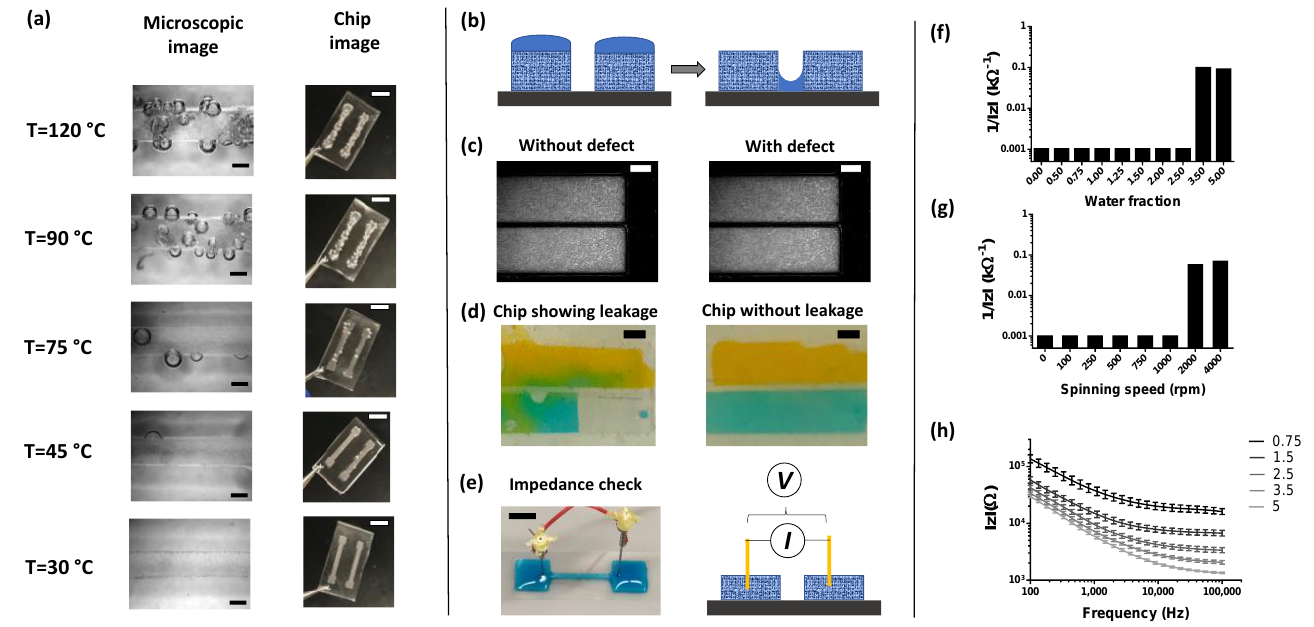
Figure 6. Effect of curing temperature and electrical impedance-based mold defect detection. ( a ) Several photos of PDMS chip cured at different temperature. It can be seen that at higher temperatures, the water from the mold evaporates, resulting in bubbling in the polymer solution. The scale bars represent 1 mm distance for microscope images and 5 mm for device photos. ( b ) Schematic showing a defect where the two channels which are separate get connected because of coalescence of water. Such defect is not visible as seen in ( c ) and can be seen in the fabrication chips after leakage test ( d ). Liquid molding offers a distinct advantage in detecting such defects by using impedance measurements ( e ) by using a two-electrode setup. A defect such as discontinuity can be detected by observing the jump in impedance profiles. ( f ) An example of a defect in the mold caused because of coalescence detected pre-molding process. ( g ) An example of a defect in the mold post molding operation caused by coalescence due to spinning the mold during the molding step. ( h ) Impedance-frequency spectra for various water fractions of the mold showing such curve can be used to create calibration plot for knowing the amount of water added in the mold. All the scale bars represent 1 mm distance for images in ( c – e ).